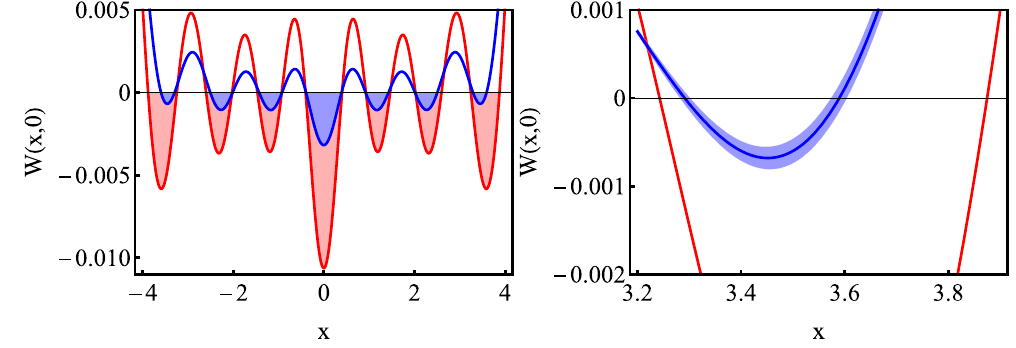
Figure 2. The cut through the normalized conditional output Wigner function W out ( x , 0) of the virtual procedure for n = 7. (LEFT) The negative part of the Wigner function W out ( x , 0) for the estimated realistic single-photon state ρ ˆ est(1) (blue region) and the negative part of the Wigner function W out ( x , 0) for the attenuated single-photon state with η = 0.838 exhibiting the same mean photon number as ρ ˆ est(1) (red region). For the state ρ ˆ est(1) , M = 2 and for the attenuated single photon state, M = 1. (RIGHT) The zoom-in to the region of the negative annulus with the largest diameter, where the blue area displays the statistical error of the Wigner function W out ( x , 0) (blue line) compared to the Wigner function W out ( x , 0) for the attenuated single-photon state with η = 0.838 (red